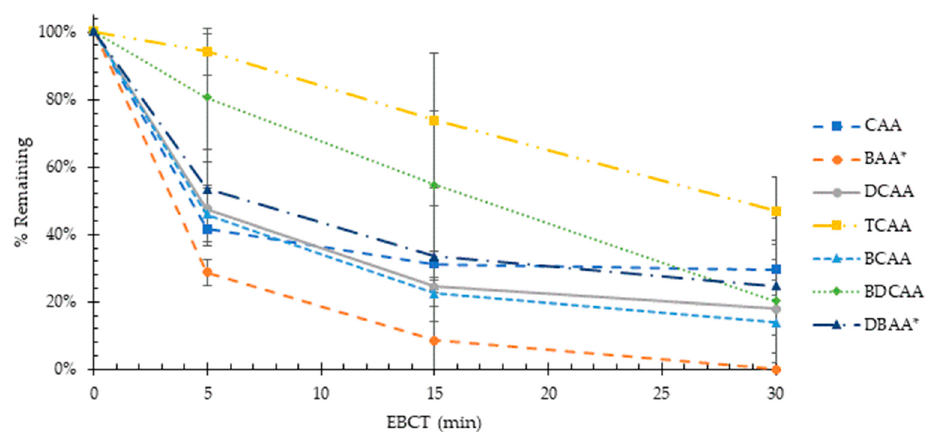
Figure 5. Removal of chloroacetic (CAA), bromoacetic (BAA) *, dichloroacetic (DCAA), trichloroacetic (TCAA), bromochloroacetic (BCAA), bromodichloroacetic (BDCAA), and dibromoacetic (DBAA) * acids after a single pass through a biological filter. EBCT = empty bed contact time. N = 9. * Formed below the limit of quantification. Error bars represent standard deviation.